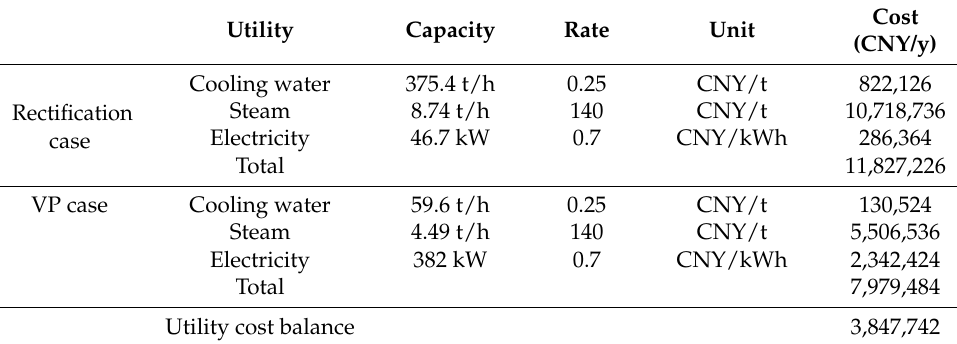
Table 3. Utility costs for rectification case and VP